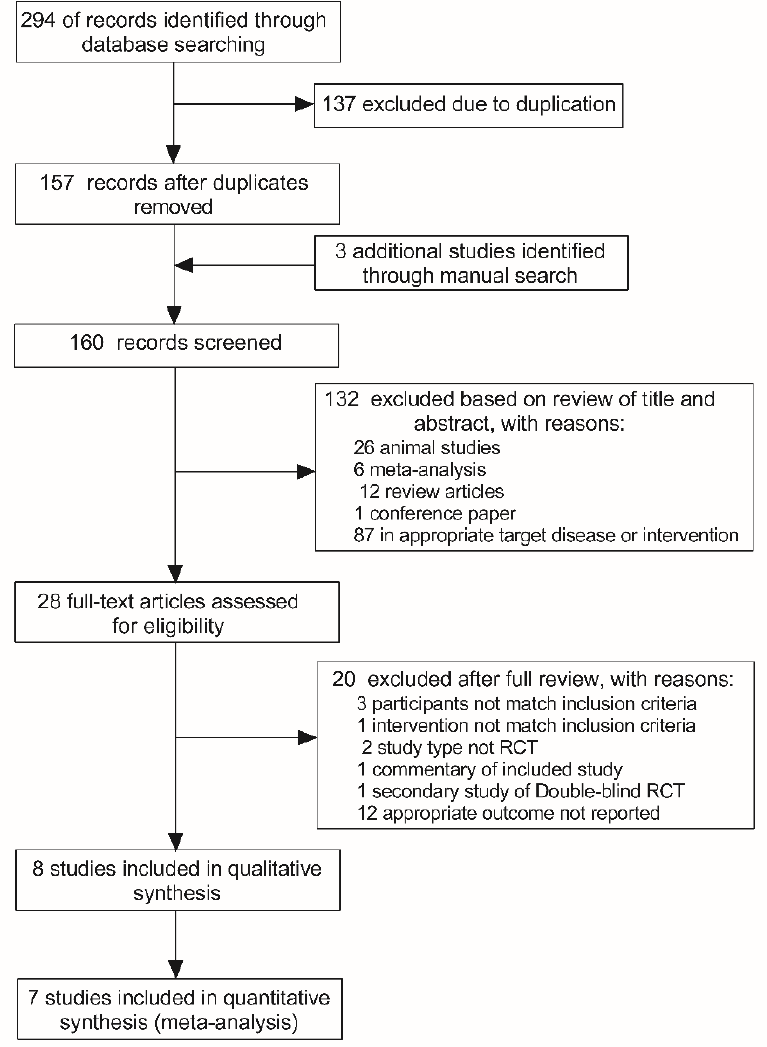
Figure 1. Flowchart illustrating the study selection process.